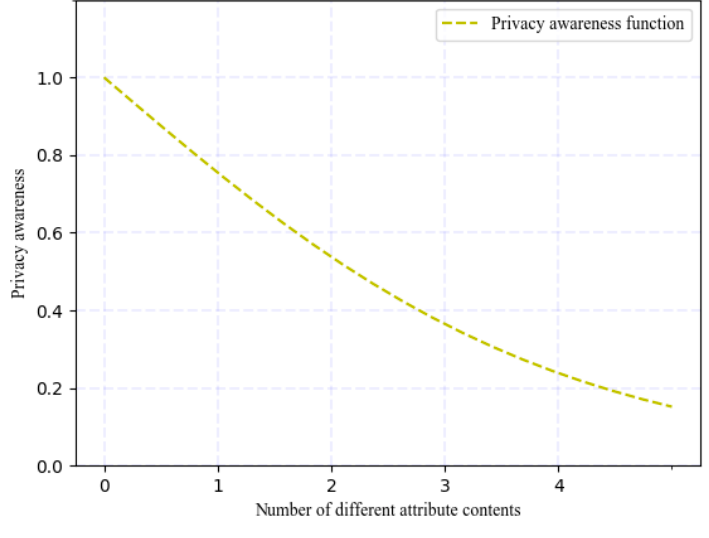
Figure 2. Privacy Figure 2. Privacy awareness.